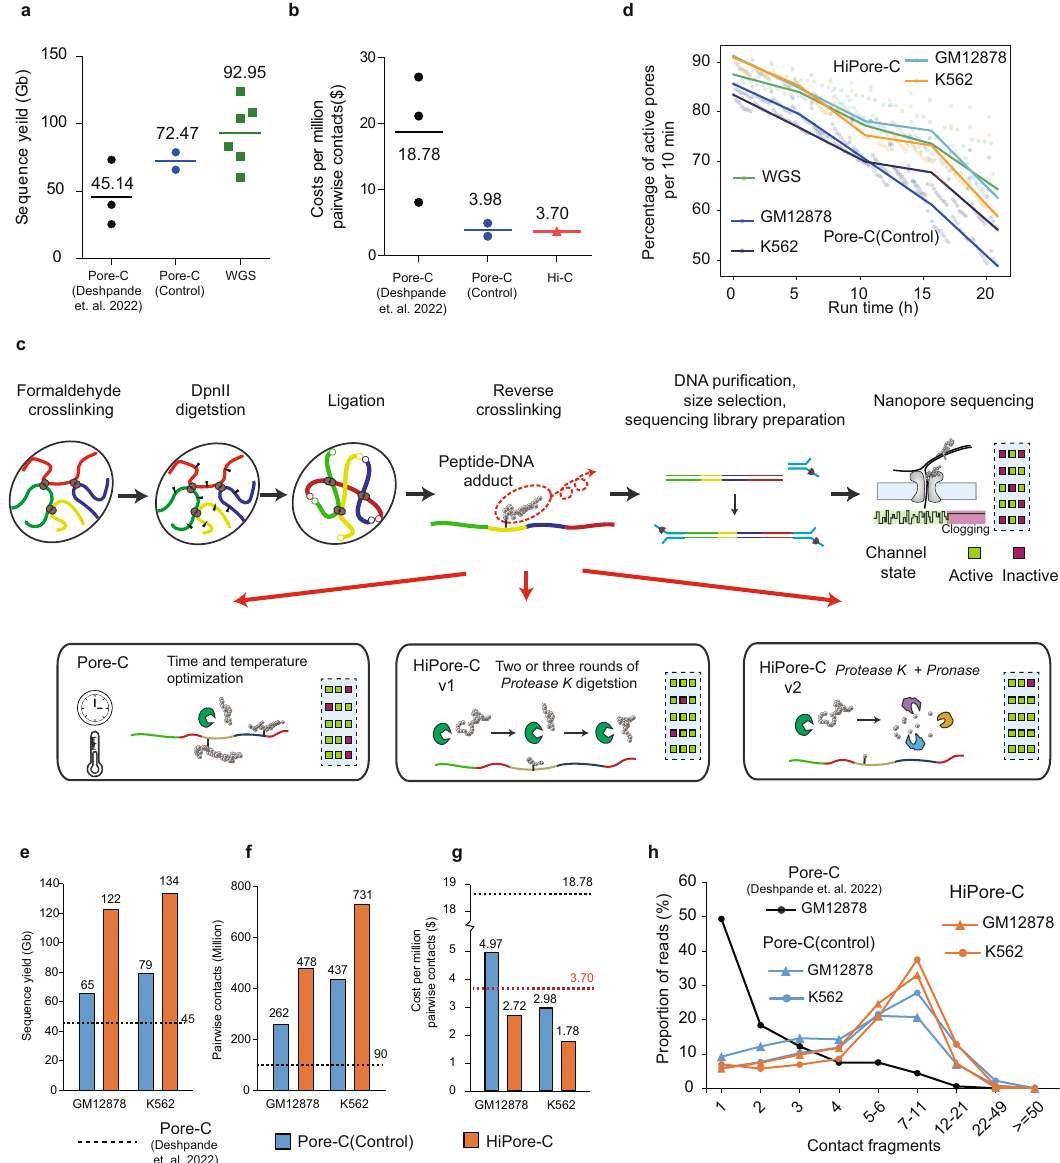
Fig. 1 | Solving nanopore clogging increases the output of multiway contact sequencing. a Comparison of the sequencing yield (Gb) between Pore-C and whole-genome sequencing (WGS) using ONT PromethION fl ow cells. Datasets of Pore-C (Deshpande et al., 2022) 57 and Pore-C (Control) were published and gen- eratedin thisstudy, respectively (Pore-C 57 , n =3;Pore-C control, n =2;WGS, n =6). Linesindicatethemeanvalues.RelatedtoSupplementaryTable1. b Comparisonof the costs per million pairwise contacts between Pore-C and Hi-C (Pore-C 57 , n =3; Pore-C control, n =2). The cost of Hi-C is estimated based on the output of the IlluminaNovasequencingplatformandthepercentageofpairwisecontactsthatHi- C cantypically produce. Linesindicate the meanvalues.Related to Supplementary Table 2. c Schematic of the in situ HiPore-C protocols for generating higher-order chromatin interactions. Condition optimization for reverse crosslinking and the